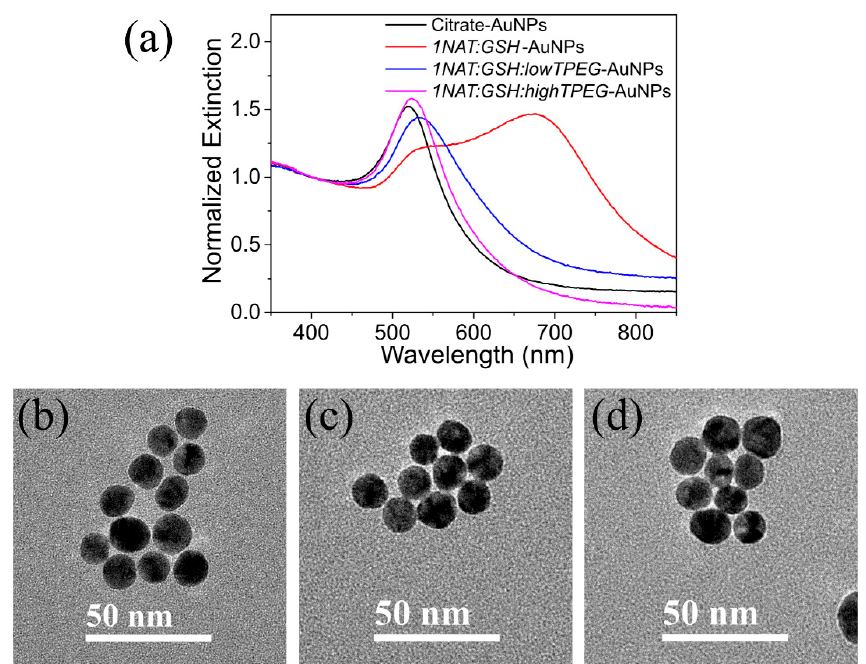
Figure 1. ( a ) UV-vis spectra of the multifunctional AuNPs set in comparison with initial citrate-AuNPs (black spectrum). Clearly, 1NAT:GSH:highTPEG -AuNPs shows the highest colloidal stability,